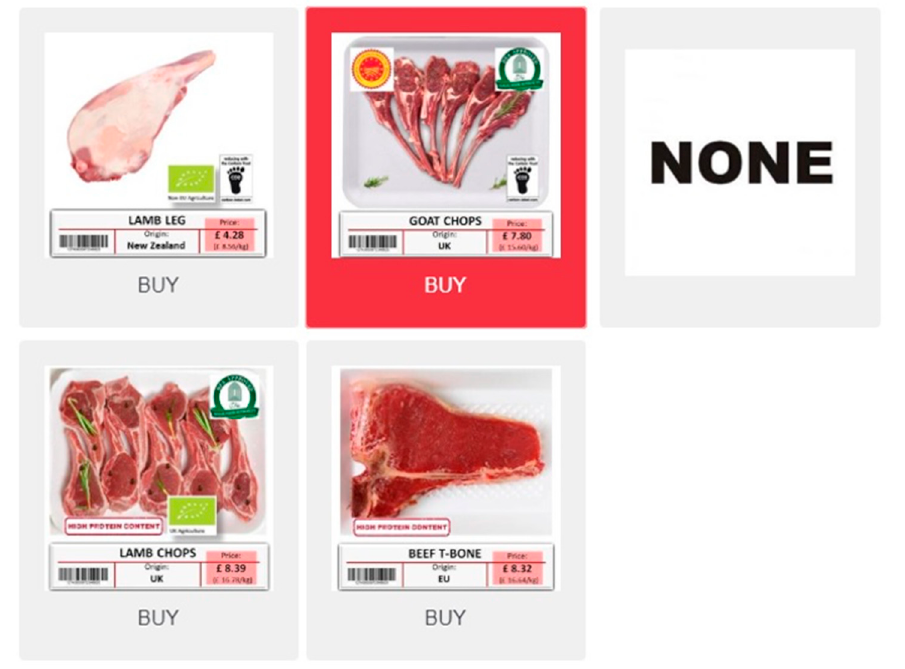
Figure 1. Example of a choice set.